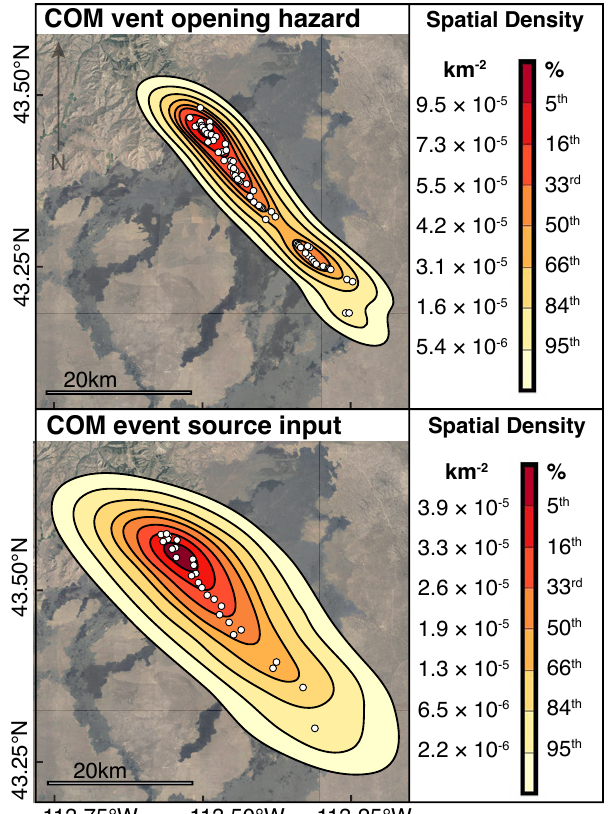
Figure 11: Vent opening hazard map and event eruptive source parameter input map for Craters of the Moon. Map background data: Google,